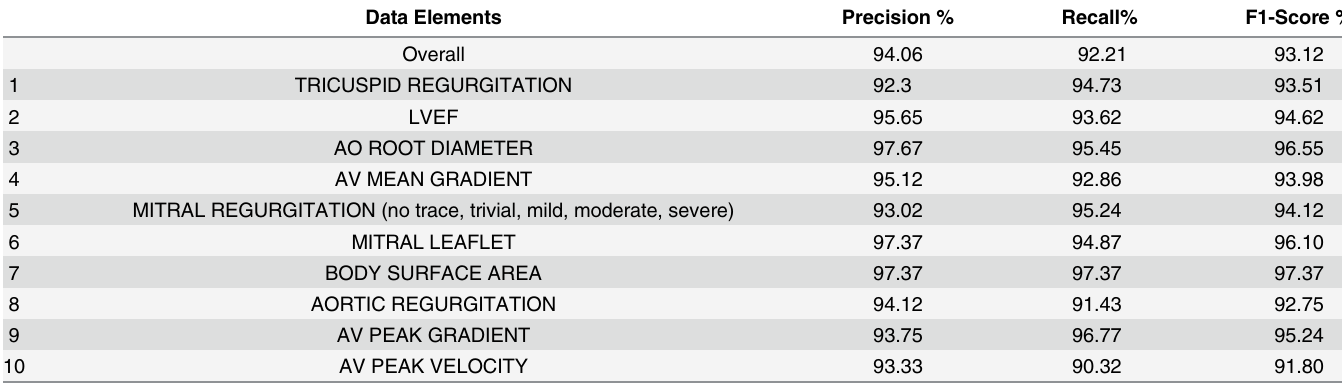
Table 3. Precision and Recall for ten most frequent data elements identified in 15,116 echocardiograms.